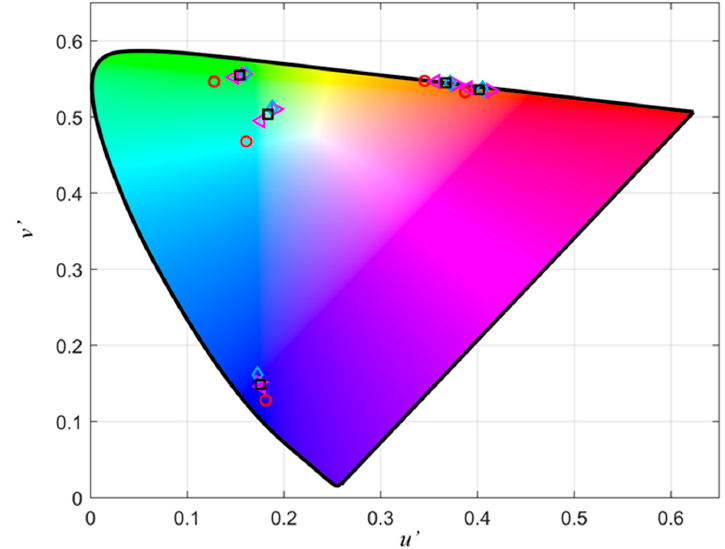
Figure 4. Miscalibration effects on the UCS of the [Ln 2 (L c2 ) 3 ] series for unapplied instrumental correction function (red circles), wavelength shifts of ±2.5 nm (magenta triangles), and spectral data in normalised photon counts (blue diamonds) compared to the correct values (black squares).